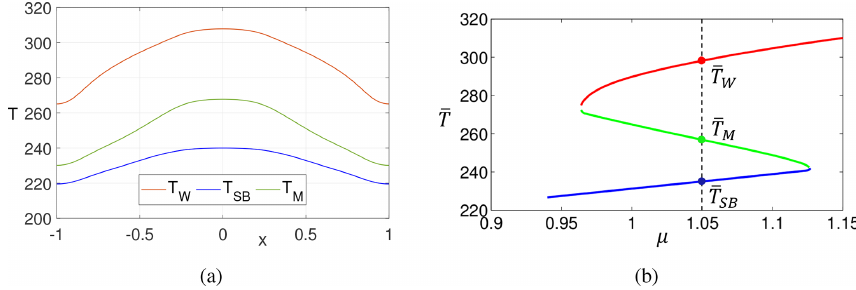
Figure 1. (a) Stationary solutions T W (x) , T SB (x) , and T M (x) in Kelvins (K) of the zonally averaged energy balance model Eq. (1). (b) Bi- furcation diagram of the average temperature T as a function of control parameter µ